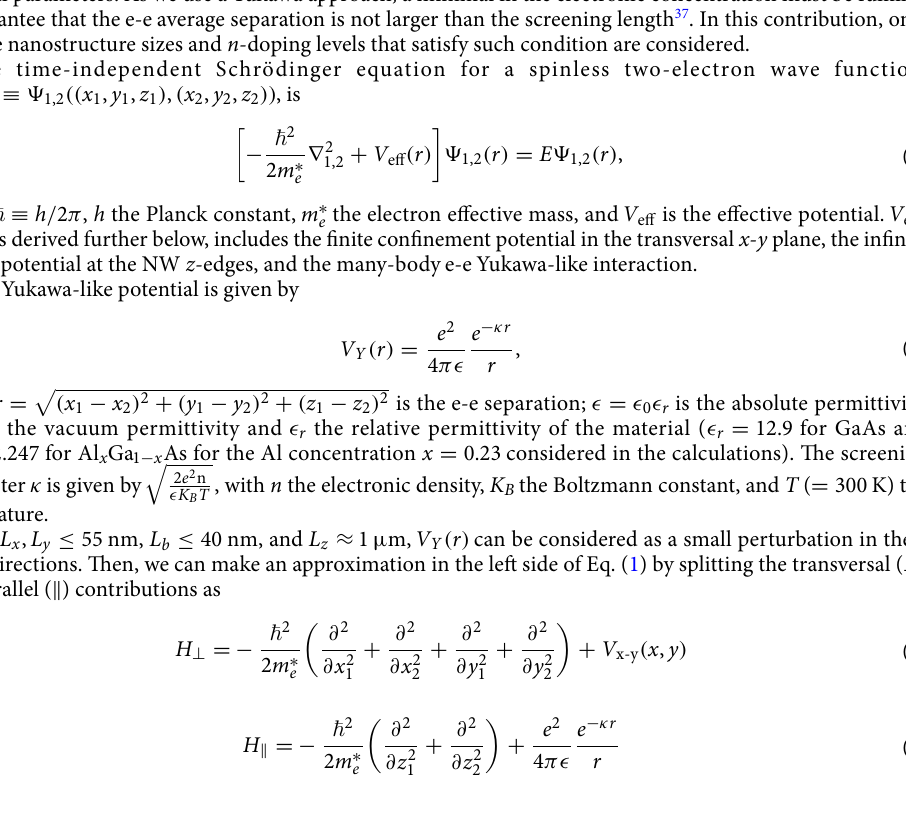
Figure 7. x – y electron configuration for the ( a ) first, ( b ) second, and ( c ) third excited states in a 6 array with L x , y 20 nm and L b 3 nm. The distributions are obtained by considering only the x and y wave = = function